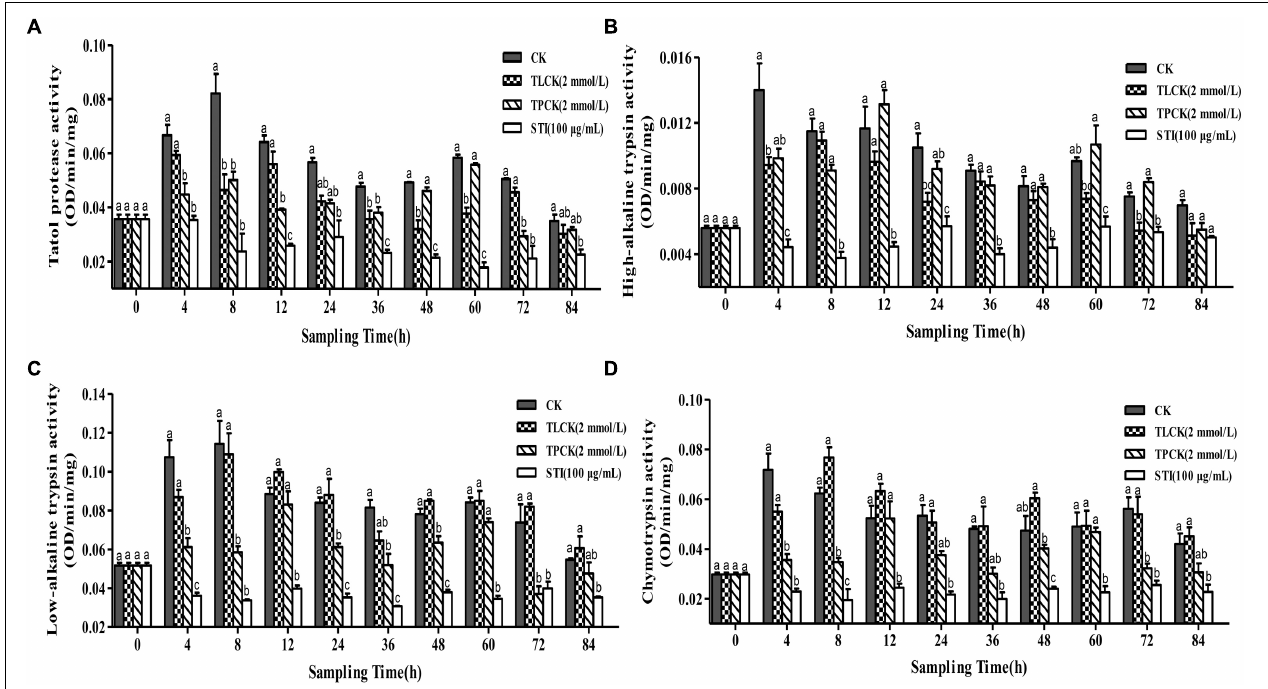
FIGURE 2 | Effects of ingesting different protease inhibitors, TLCK, TPCK, and STI, on the midgut protease activity of Plutella xylostella larvae. (A) Total protease. (B) High-alkaline trypsin. (C) Low-alkaline trypsin. (D) Chymotrypsin. Columns represent means of three independent values and their SEM. Different lowercase letters indicate significant difference at P < 0.05 using Tukey’s HSD